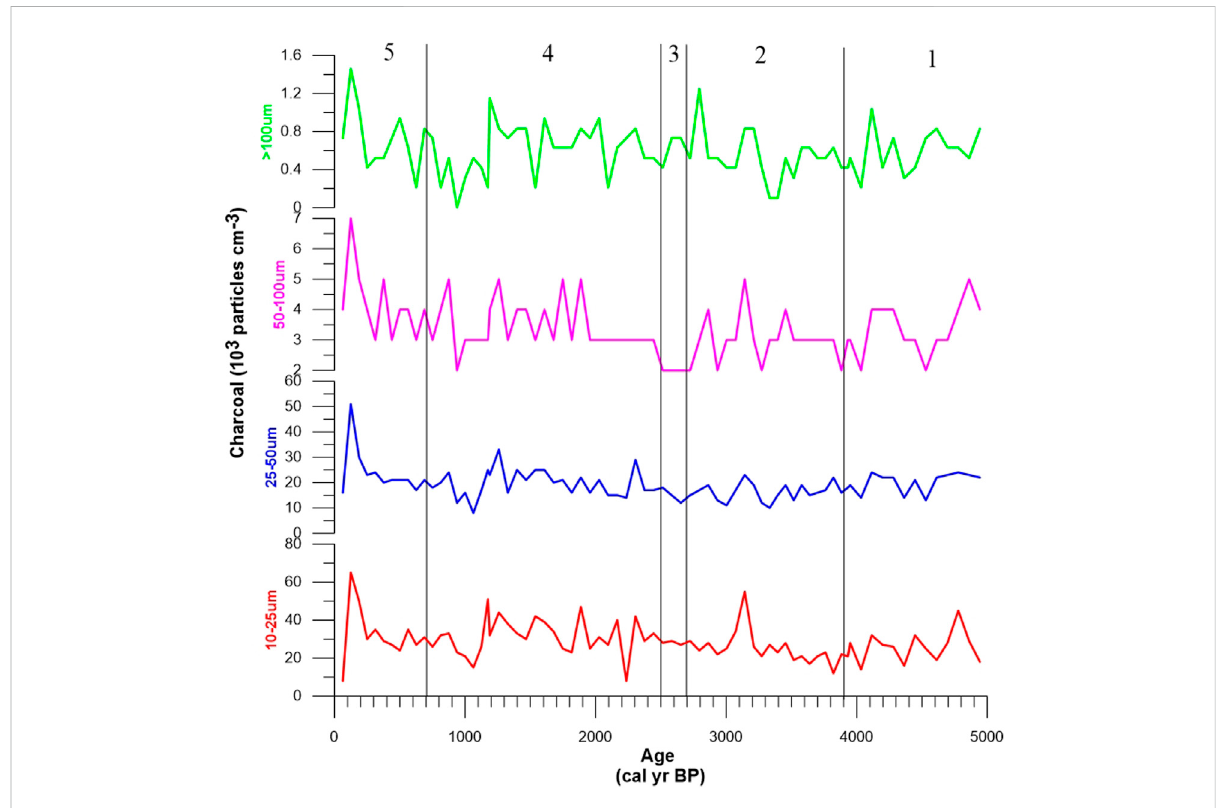
Diagrams showing charcoal concentrations in the KLA section.